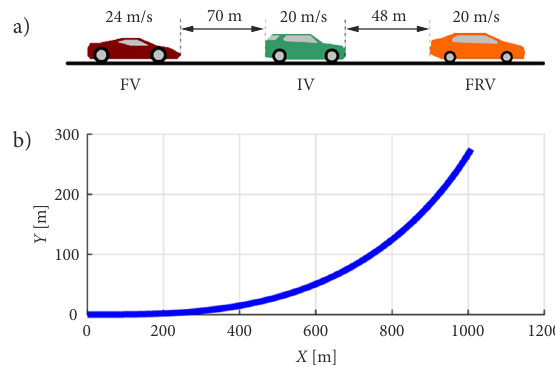
Figure 8. Initial motion states and road path (source: created by the authors): a – initial speeds and clearances; b – path; FV –